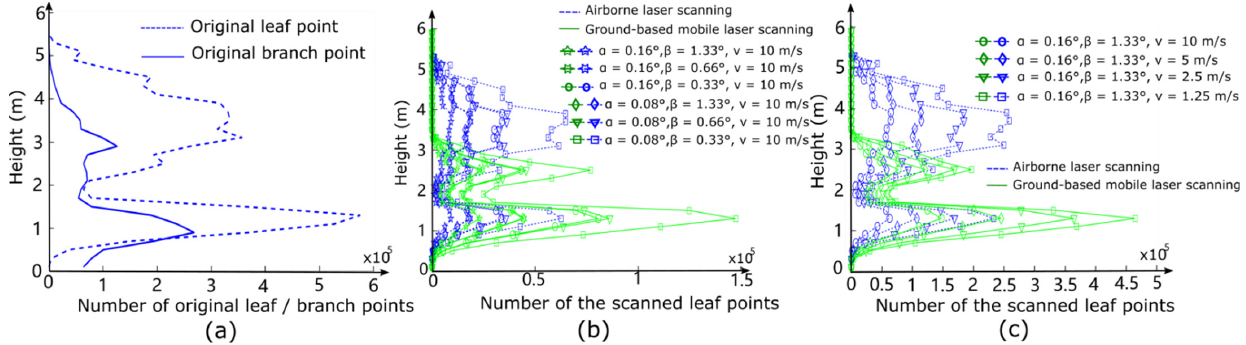
Figure 6. The vertical profile of the vegetative element distribution is in the form of discrete points. ( a ) The vertical profile of the original sampling points compared to the vegetative elements. ( b ) Ver ‐ tical profiles of the acquired scanned points versus the variation in the tuning of scanned angular resolution with an unchanged velocity of the vehicle loading LiDAR sensors. ( c ) Vertical profiles of the acquired scanned points versus the variation in tuning vehicle velocity with an unchanged scan ‐ ning angular resolution. Through the comparison between ( b , c ), the number of the collected point clouds shows that the effect of adjusting velocity outperforms that of the scanning angular resolu ‐ tion in the acquisition of high ‐ density point cloud data for the same forest plot.